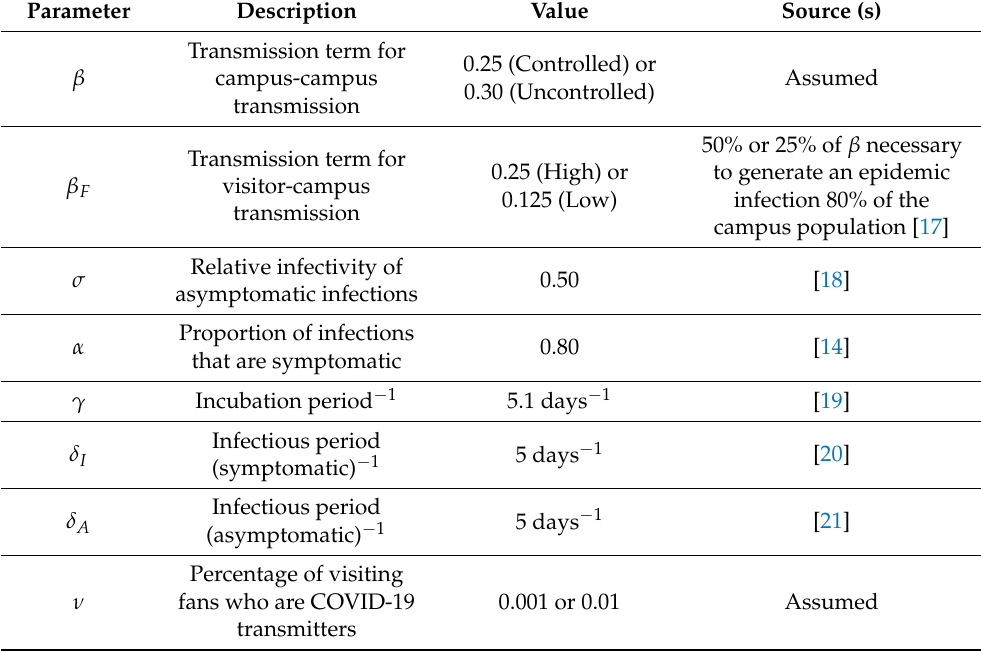
Table 2. Parameters for a model of COVID-19 transmission due to in-person sporting events.